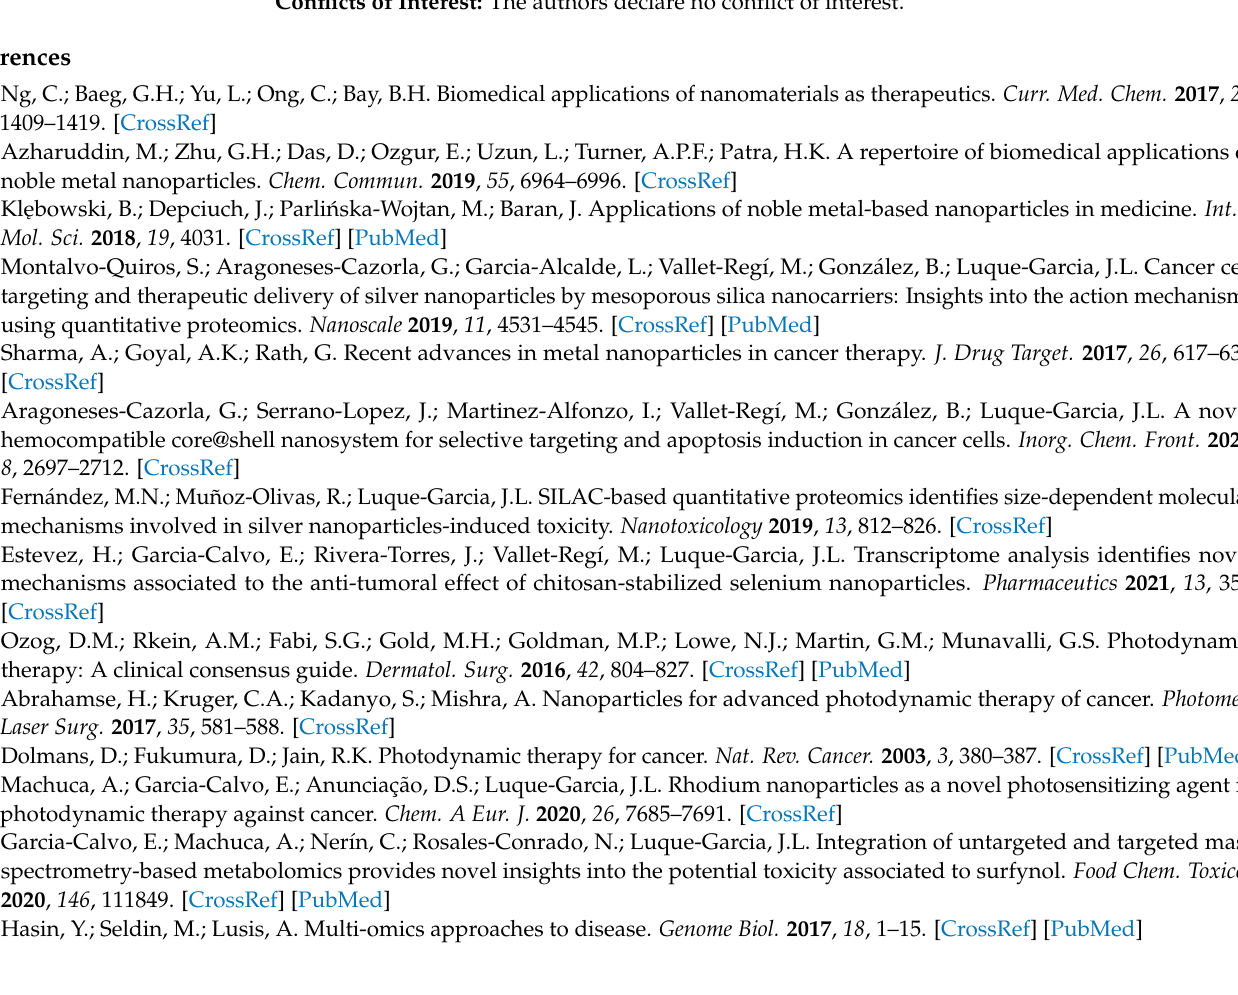
Figure S2: Representative chromatograms obtained in TIC mode for metabolite extracts from control ( A ) and treated ( B ) samples; Table S1: Transitions and collision energies used for the quantification of ATP, ADP, NADH and NAD + by LC-QqQ-MS working on MRM mode; Table S2: Whole transcriptome analysis of HeLa cells exposed to RhNPs and NIR; Table S3: Common metabolites identified in control and treated samples by GC-TOF-MS with a minimum NIST Rmatch value of 700; Table S4: Pearson’s correlation matrix data for the 48 identified metabolites; Table S5: PCA score values for controls and treated samples on the